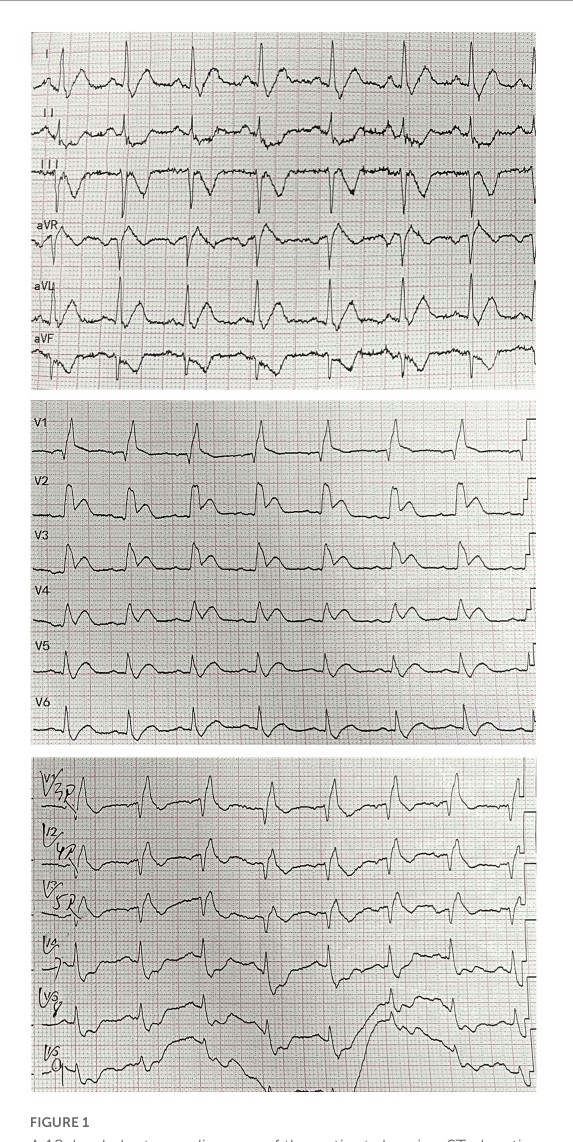
FIGURE1 A 18-lead electrocardiogram of the patient showing ST elevation in V2–V4 leads with widespread inverted T-waves in inferior, posterior, and right ventricular